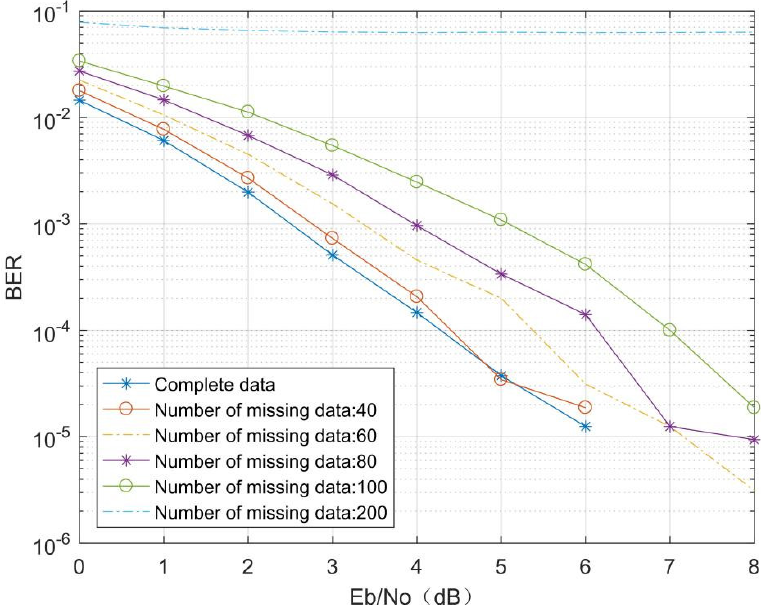
Figure 10. Decoding comparison of different missing data depth receiver.